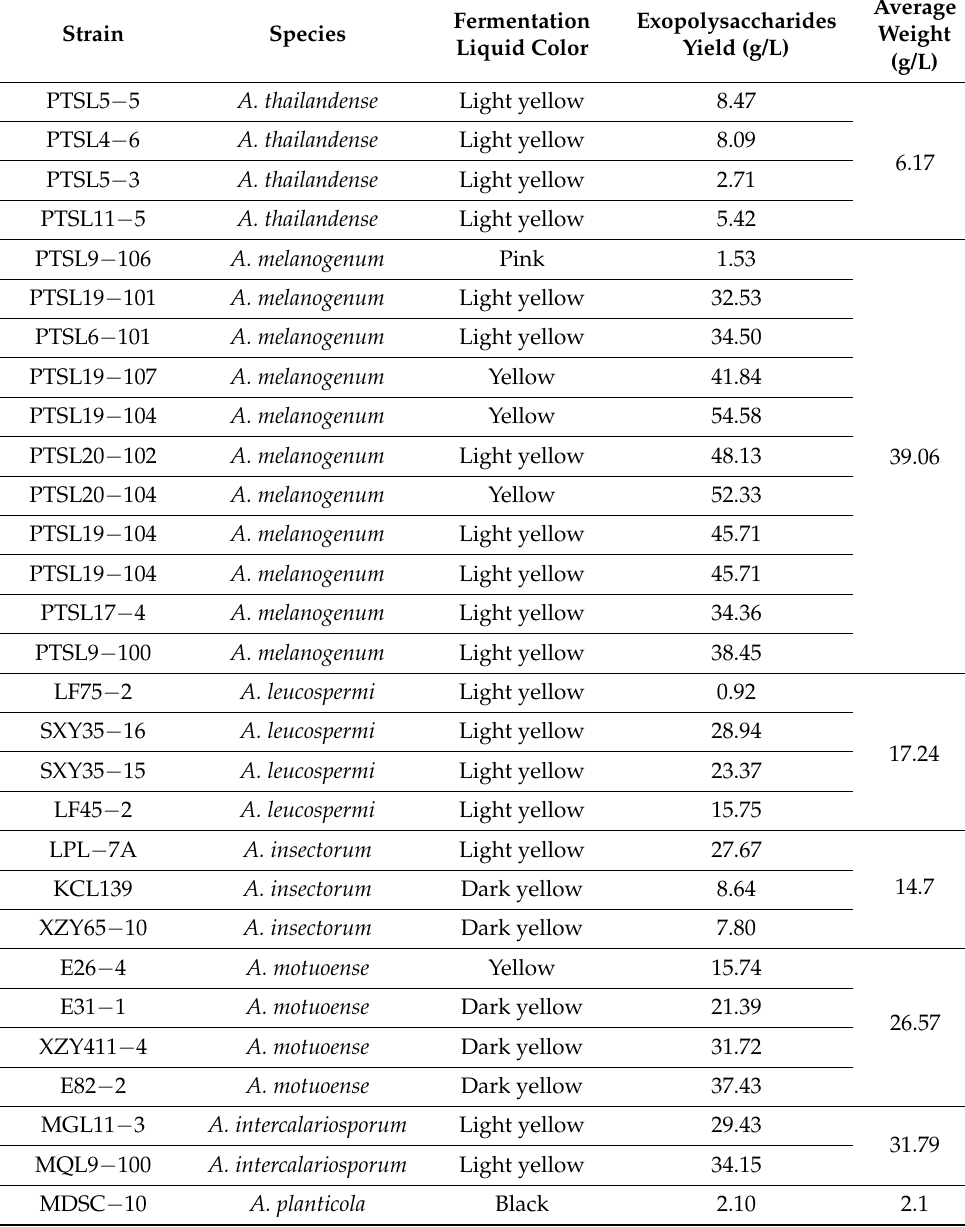
Table 2. Exopolysaccharides production yield (EPY) of Aureobasidium .